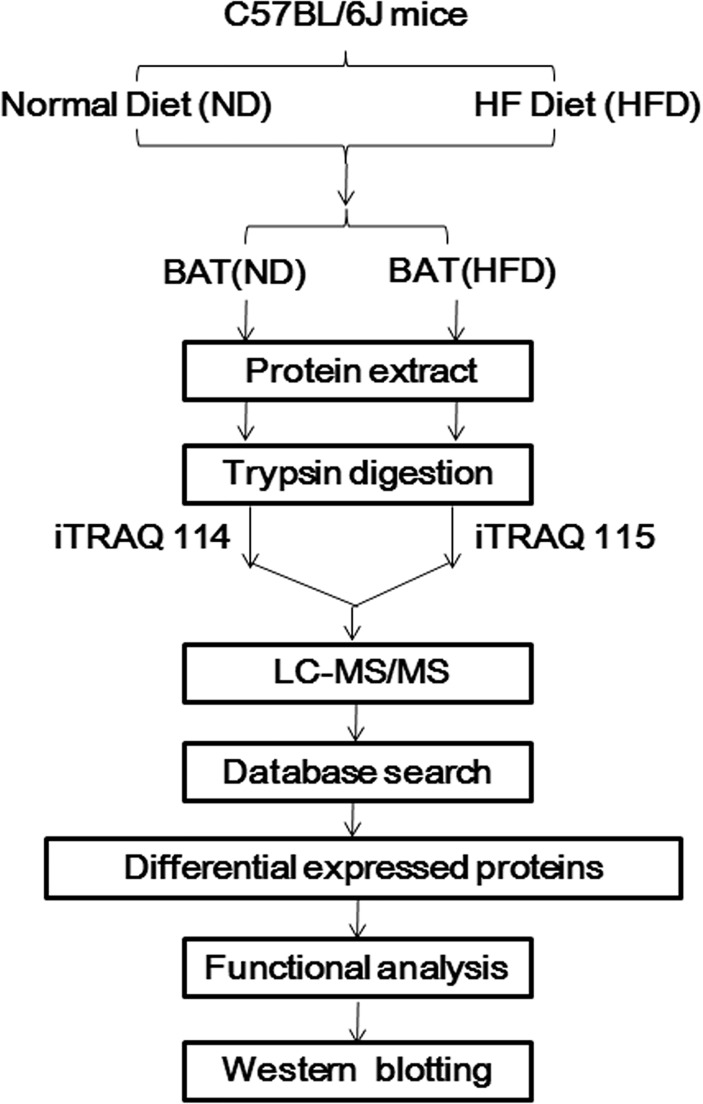
Work flow of establishing obese mice model and proteomic analysis of BAT proteins.Female C57BL/6J mice were fed normal diet (ND) or high-fat diet (HFD) start at 6–8 weeks of age. Glucose tolerance test (OGTT) and hyperinsulinemic-euglycemic clamp were applied to assess the insulin sensitivity in mice after 22 weeks. The levels of blood lipid were tested as the auxiliary evaluation indexes of metabolic state. Proteins of BAT in ND and HFD group were quantified via iTRAQ-coupled 2D LC-MS/MS. After comparing the differential expressed proteins between HFD group and ND group, functional analysis of those differential proteins of BAT indicated the important role of BAT in obesity. Finally, western blot analysis was performed to validate the variation of three key differential proteins.